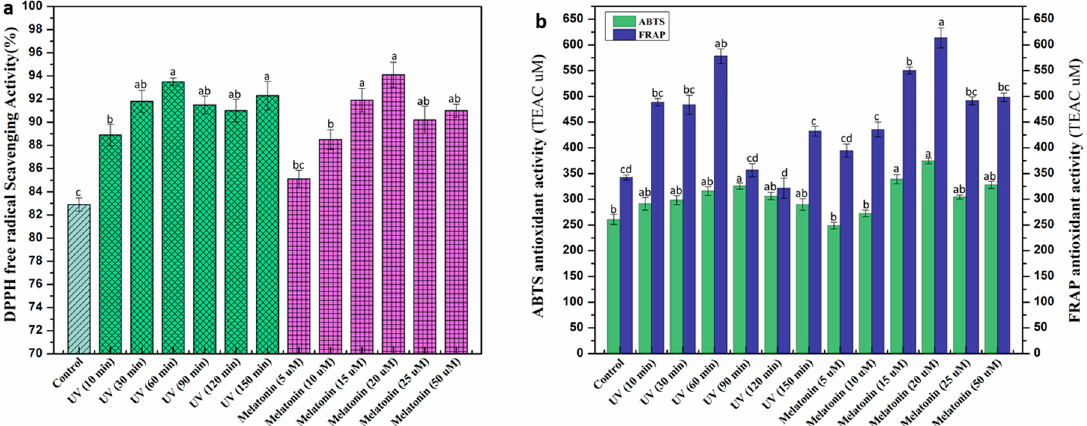
Figure 4. Influence of elicitors on antioxidant enzymatic activity of L. sativum calli extracts. ( a ) peroxidase (POD), ( b ) superoxide dismutase (SOD). Values represent means ± standard errors from triplicates. Columns with similar alphabets (letters a–d) are not significantly different ( p < 0.05).